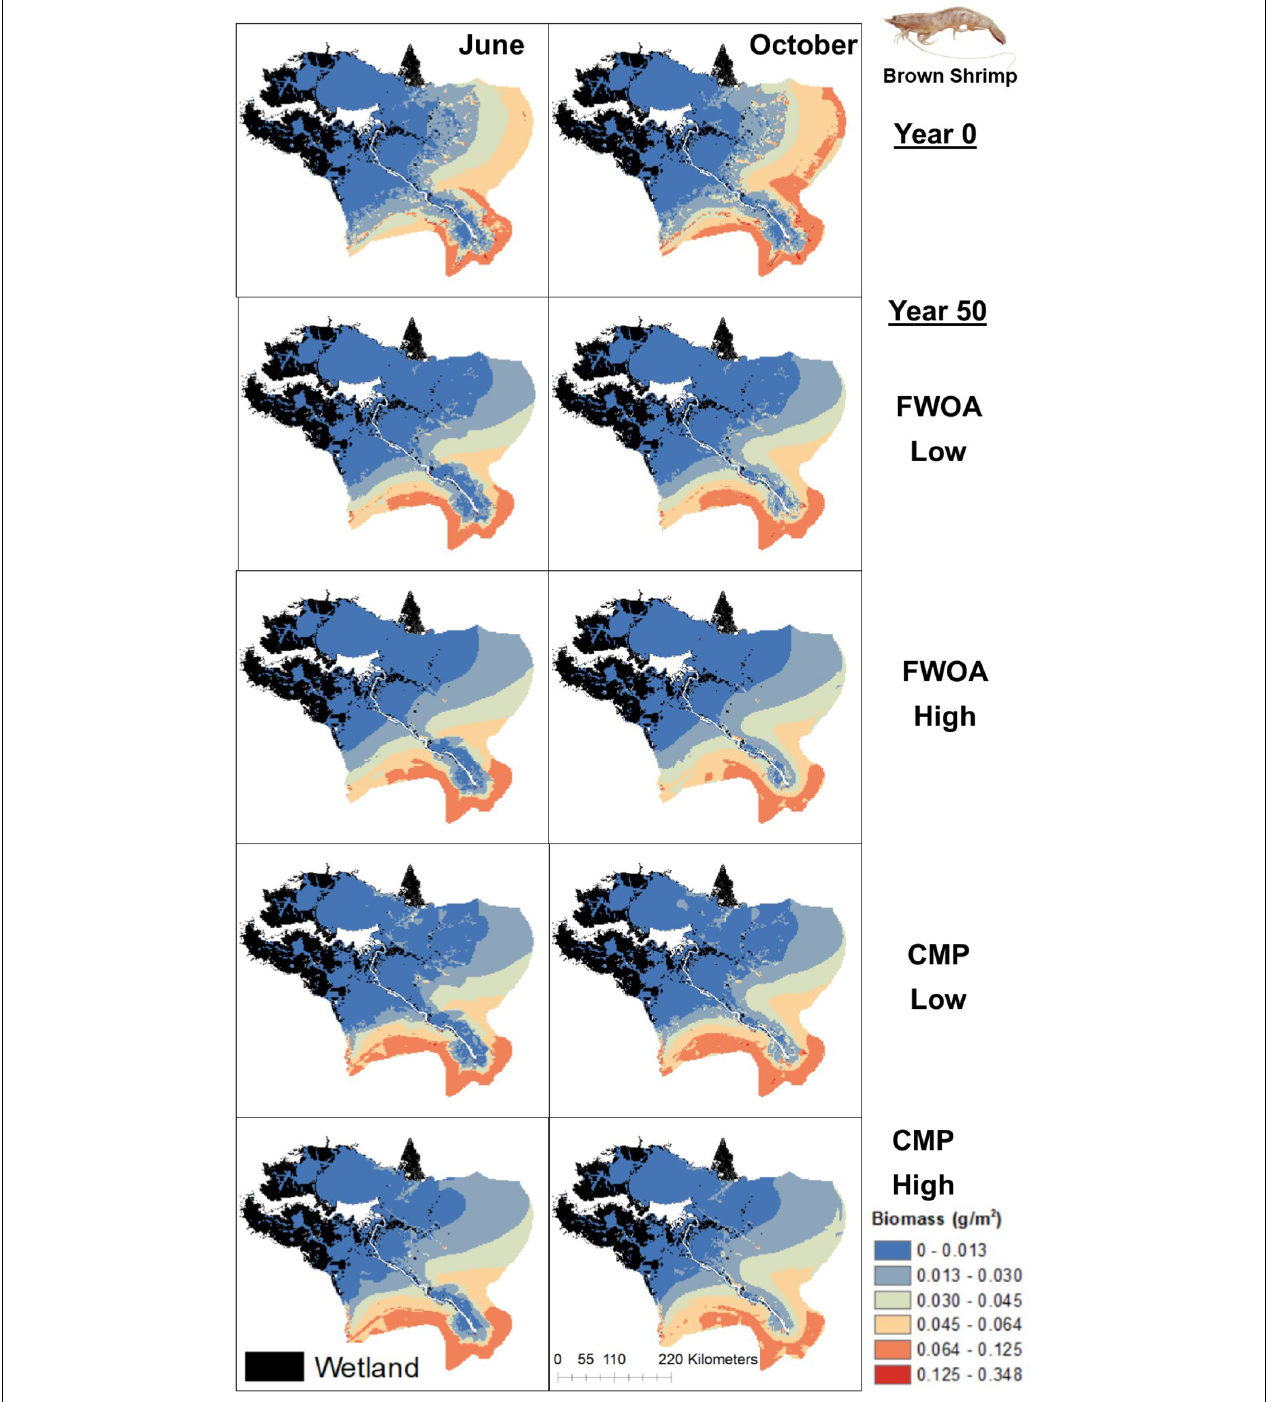
FIGURE 8 | Spatial distribution of juvenile Brown Shrimp in different simulations. Output is shown from June and October in Year 0 and Year 50, under “Low” and “High” relative sea level rise (see Supplementary Table S6 for scenarios), and with Coastal Master Plan (CMP) implementation and without (FWOA).